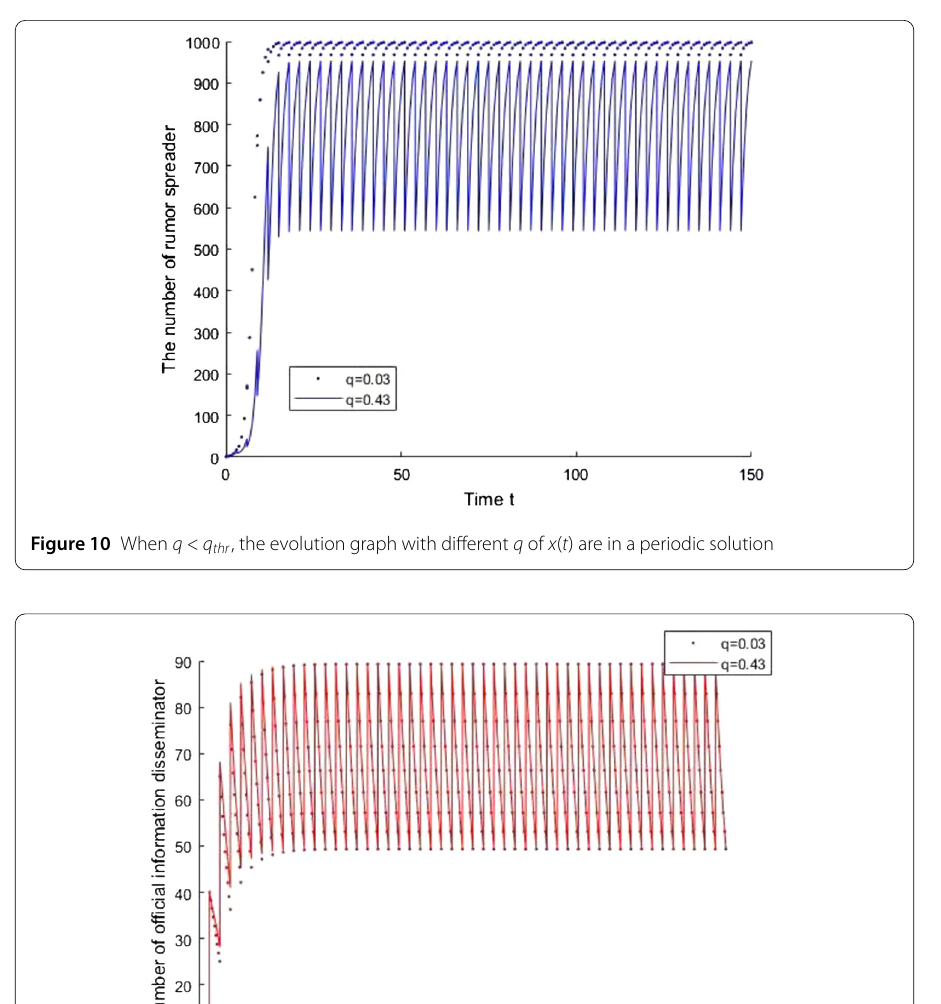
flood and the system is a persistent system, which may generate cascade reactions and trigger new emergencies. The numerical simulation confirmed our conclusion, that is to say, to eliminate social losses caused by rumors and calm down emergency effectively, the government can increasingly issue public official information of events, or increase the strength of refuting specific rumors according to the influence range of rumors